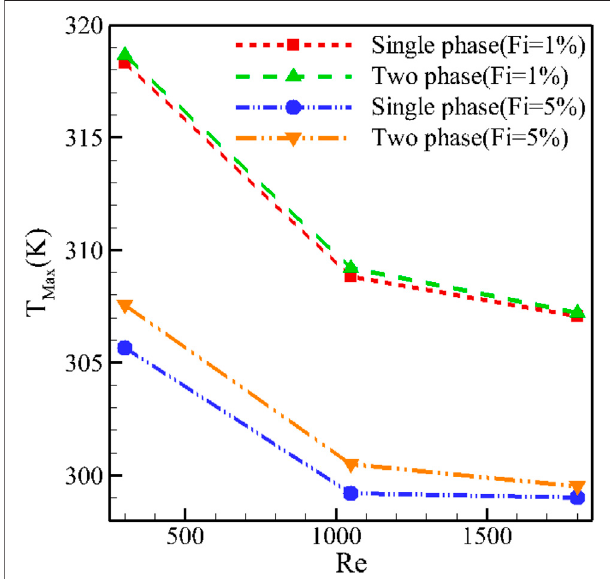
FIGURE 6 | Maximum H-S temperature at different values of Re when φ (cid:1) 2% for the T-P and S-P simulation models.